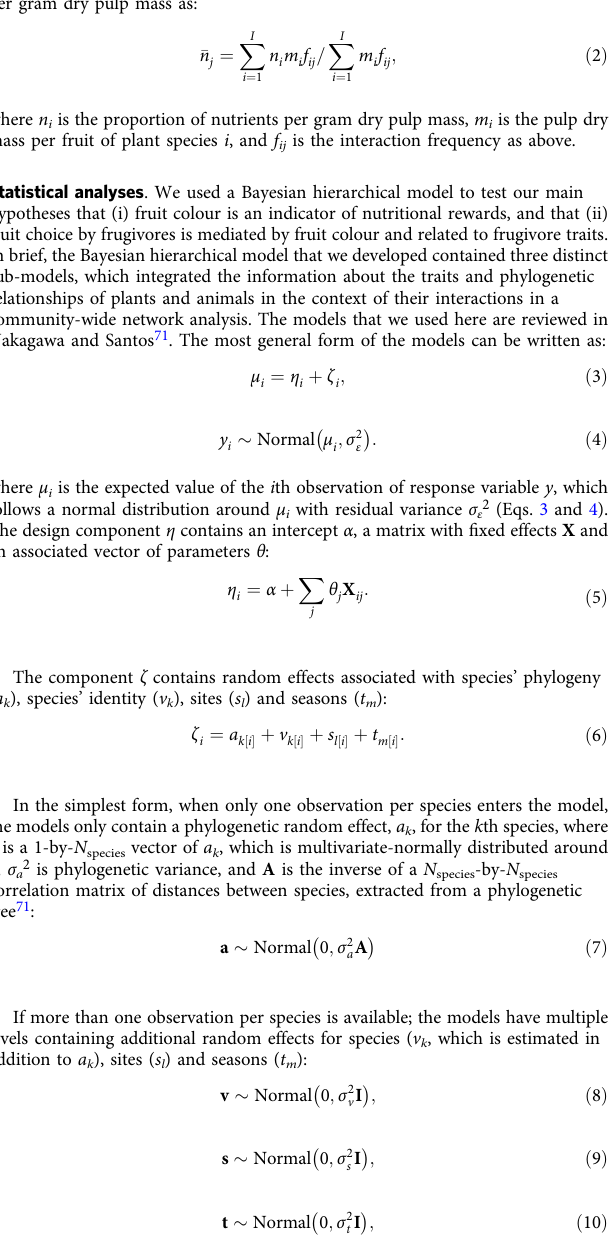
(Fig. 1b). For birds we obtained a random sample of 1000 phylogenetic trees from www.birdtree.org 70 , and calculated a maximum clade credibility tree with median node heights (Fig.